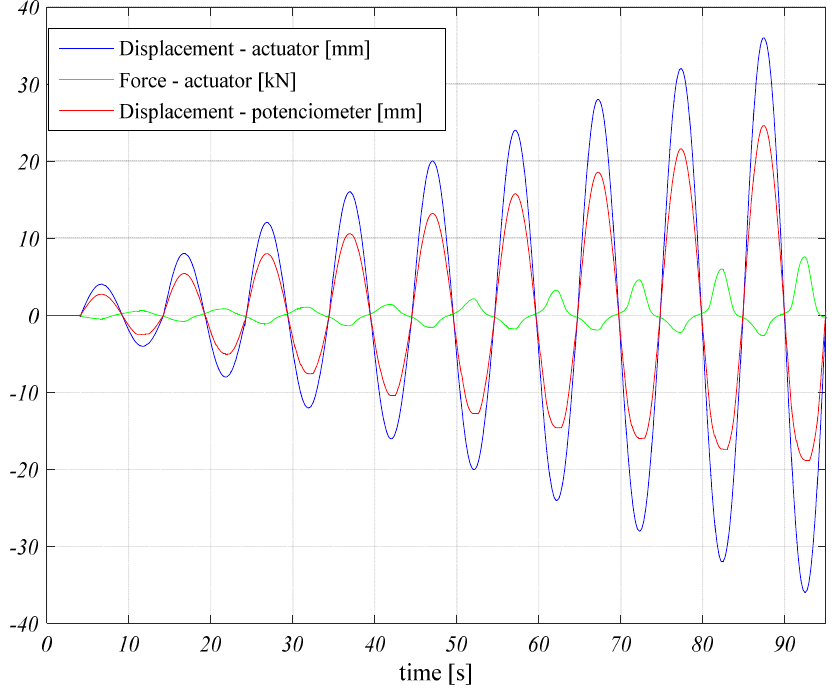
Figure 7. Time histories of the measured quantities during cyclic tests.